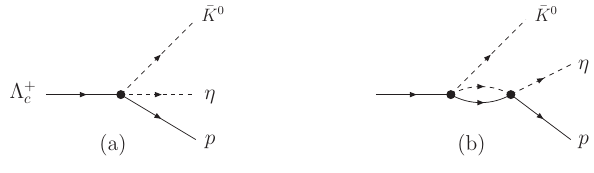
→ π 0 P + decay. c s